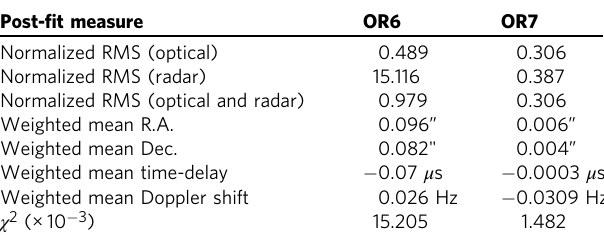
Table 1 Fit quality statistics for the OR6 gravity-only and OR7 non-gravitational orbital solutions.